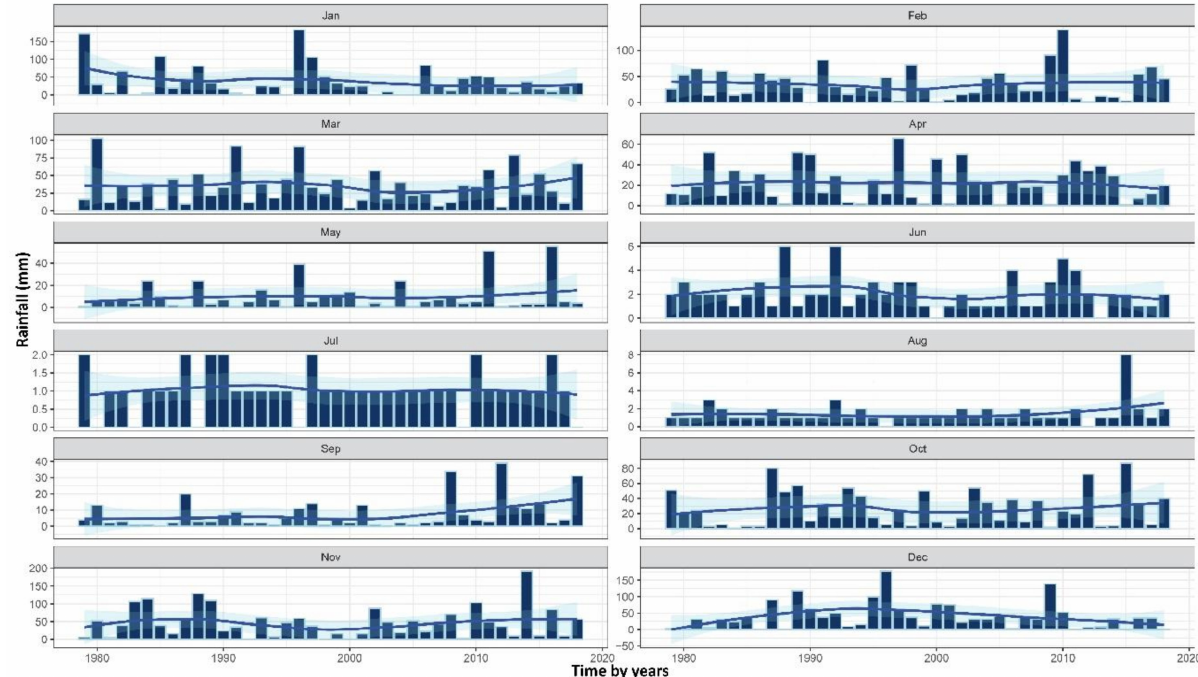
Figure 6. Monthly variation in rainfall (mm) between 1979 and